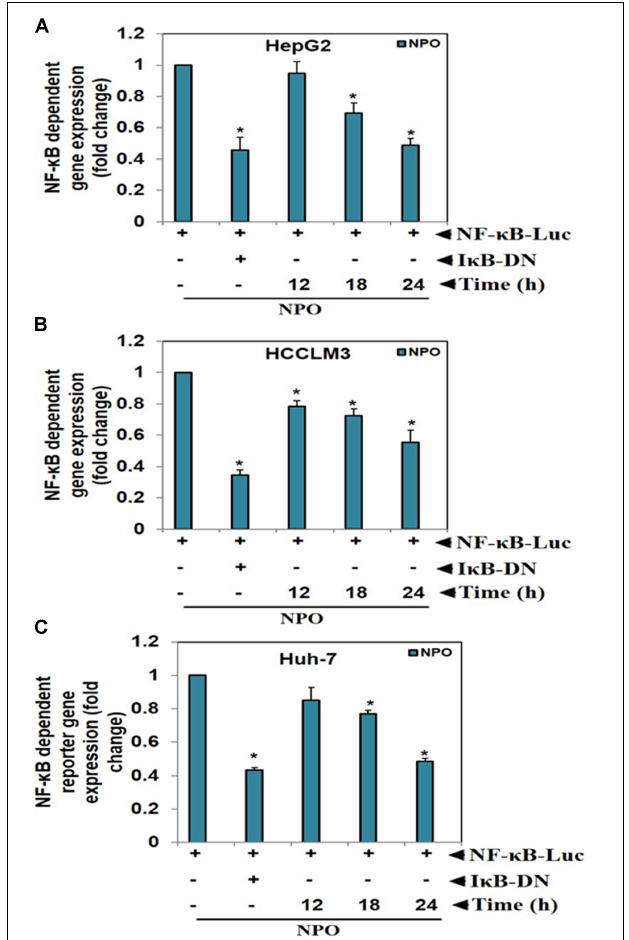
FIGURE 4 | NPO inhibits NF- κ B dependent luciferase expression in HCC cells: with NF- κ B responsive elements linked to a luciferase gene were transfected with wild-type or dominant-negative I κ B and transfected (A) HepG2, (B) HCCLM3, and (C) Huh-7 cells were treated with NPO at indicated time points and reporter (luciferase) activity was measured. All luciferase experiments were done in triplicate and repeated twice ( ∗ p < 0.05).